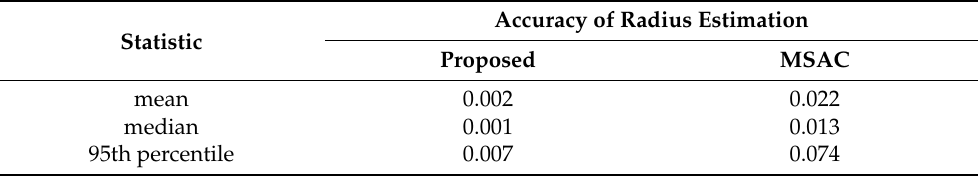
Table 2. Mean, median, and 95th percentile of the accuracy of the estimated radius using the proposed and MSAC methods.